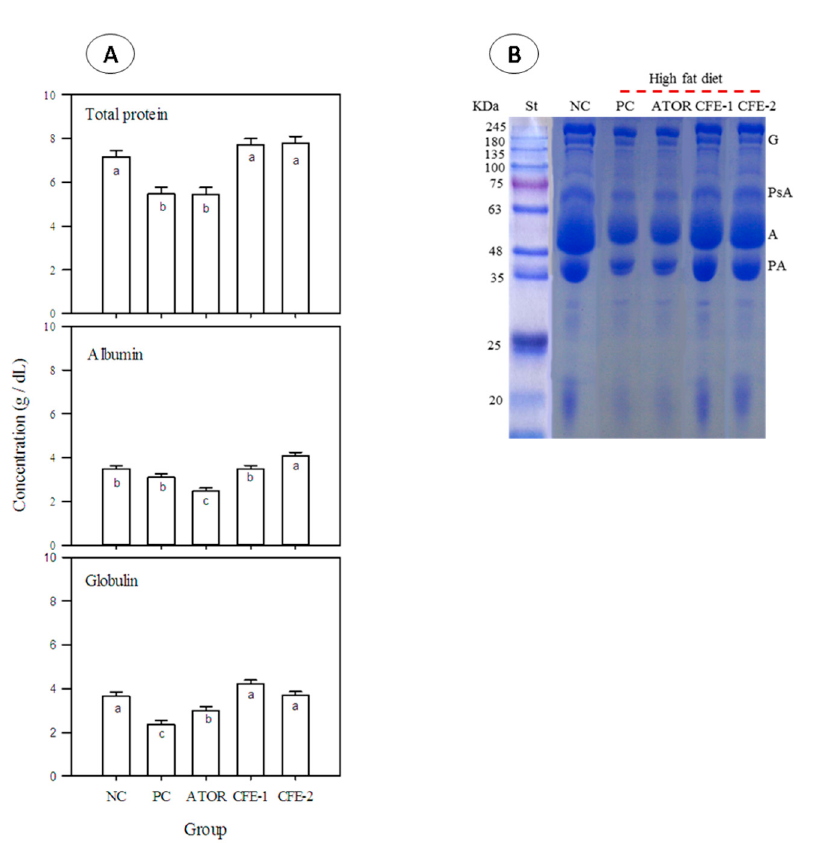
Figure 5. Total protein, albumin, globulin, ( A ) and SDS-PAGE ( B ) in the serum of male Albino rats after 9 weeks. Group 1 received a normal diet and served as a negative control (NC). Groups 2–5 received a high-fat diet, where group 2 did not receive any further treatment (Positive control: PC). Group 3 was treated with atorvastatin (ATOR) (10 mg kg − 1 ), while groups 4 and 5 were treated with Lactobacillus paracasei postbiotic (CFE-1 and CFE-2; at 100 and 200 mg kg − 1 , respectively). Values are presented as mean ± SD ( n = 8). Mean values within the same histogram with different superscripts letters are significantly different ( p < 0.05). Forty animals were divided into five groups (animals each). Postbiotic is the cell-free extract (CFE). G = globulin, PsA = post-albumin, A = albumin, and PA = pre-albumin.